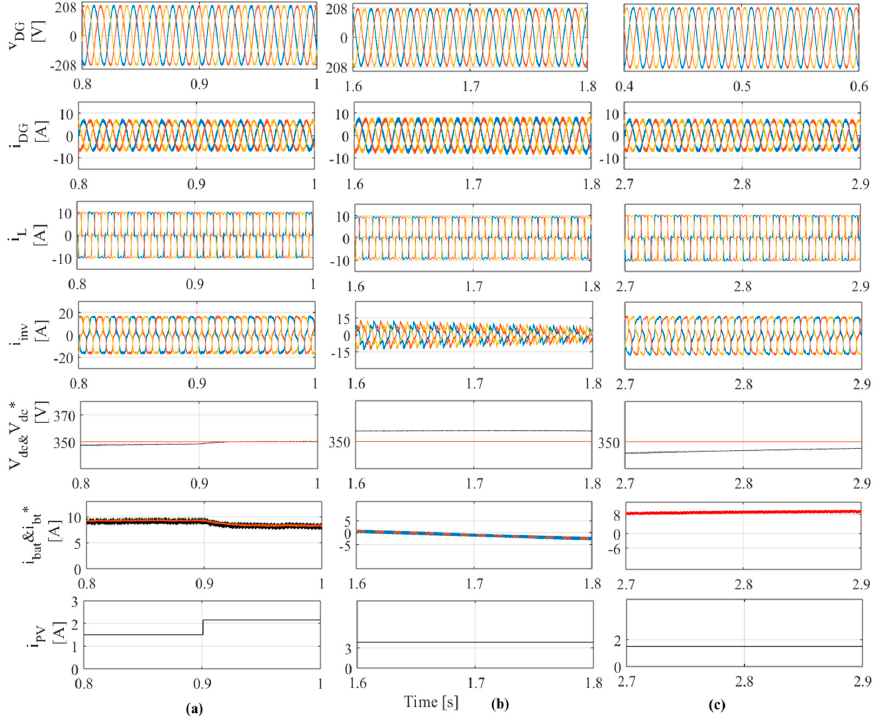
Figure 8. Zoom of waveforms of Figure 6 between ( a ) t = 0.8 s to t = 1 s, ( b ) t = 1.6 s to t = 1.8 s and ( c ) between t = 2.7 s to t = 2.9 s.